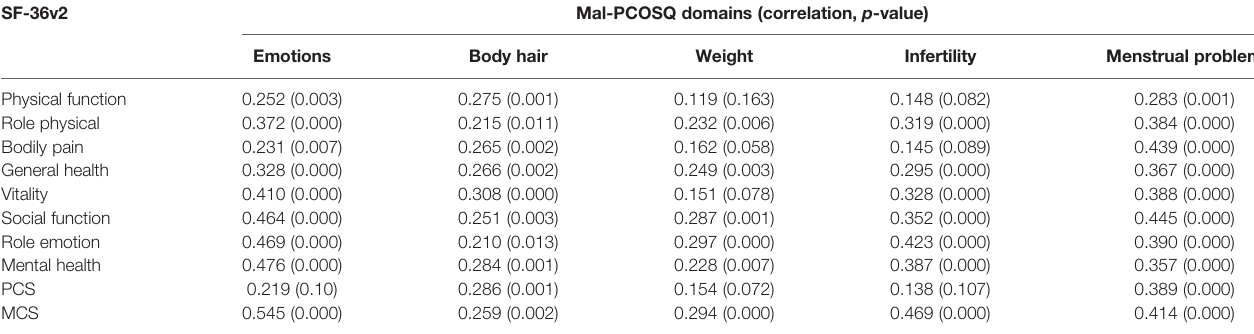
TABLE 5 | Construct validity: correlations between Mal-PCOSQ and SF-36 questionnaires.